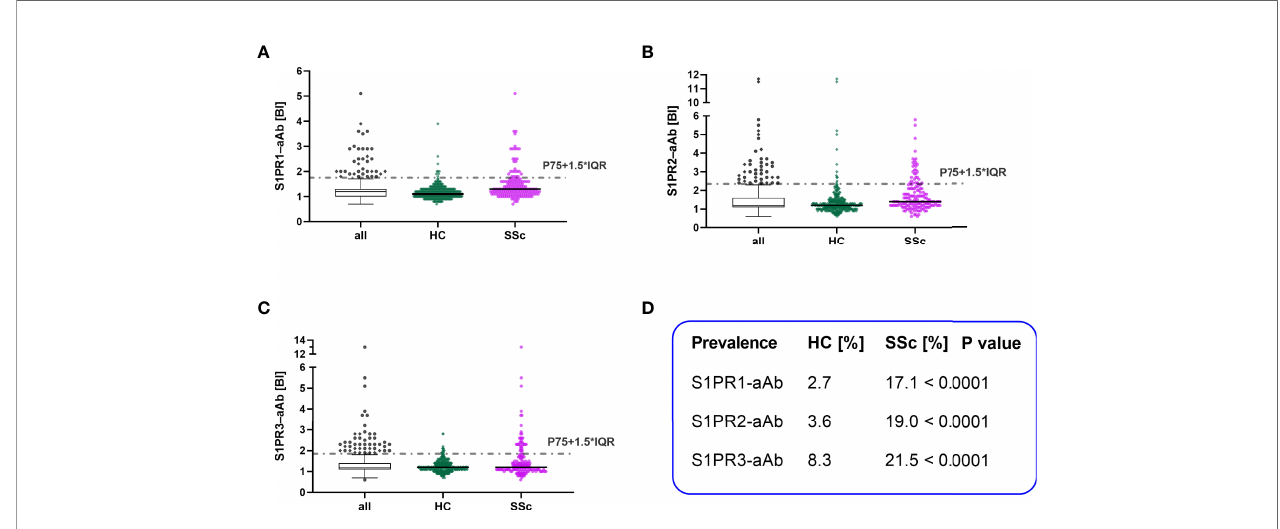
FIGURE 3 | Comparison of S1PR – aAb in healthy controls versus patients with systemic sclerosis. The presence of aAb to the three human S1PR (1 – 3) was determined in the group of healthy controls (HC) and patients with systemic sclerosis (SSc), and the relative prevalence was compared between both groups. Thresholds are indicated by dotted lines, and values are displayed as scattered dot plots. Black lines represent the median. Whiskers of the box plots denote P25 and P75. Results from HC are denoted in green and of SSc in pink. The prevalence for (A) S1PR1 – aAb, (B) S1PR2 – aAb, and (C) S1PR3 – aAb was elevated in the patient cohort as compared to healthy controls. (D) A statistical comparison of SSc and HC for S1PR-aAb was conducted by two-sided Chi square test and revealed signi fi cant group